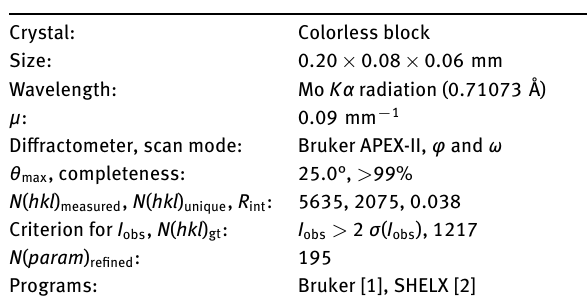
Table 1: Data collection and handling.